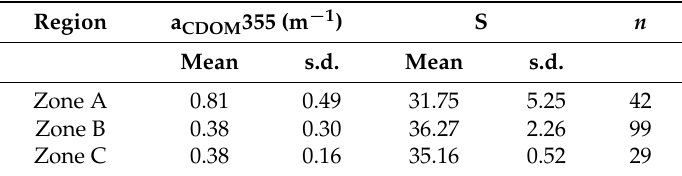
Table 2. Mean and standard deviation (s.d.) of in situ a CDOM 355 and salinity (S) measurements as a function of the area, see Figure 1. The last column shows the number of observations ( n